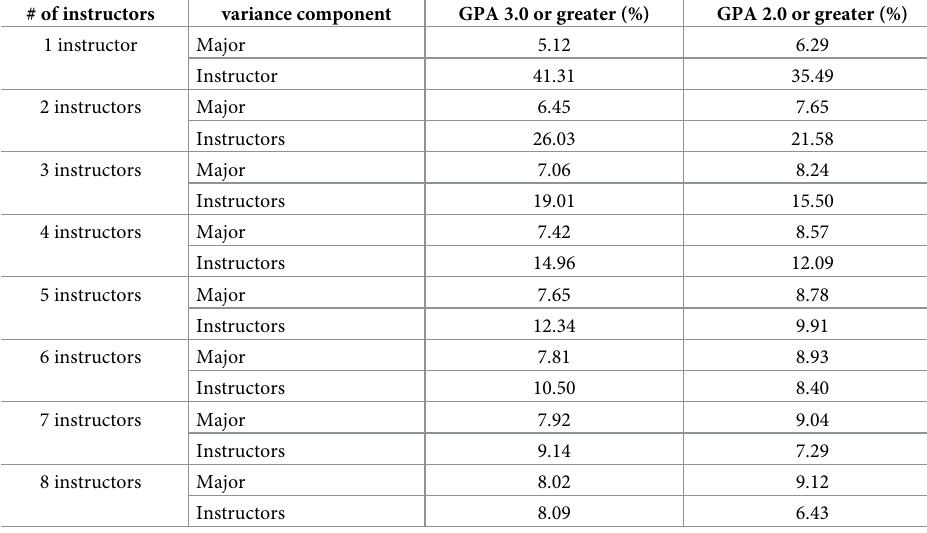
Table 4. Variance partition coefficients for GPA 3.0 or better/ GPA 2.0 or